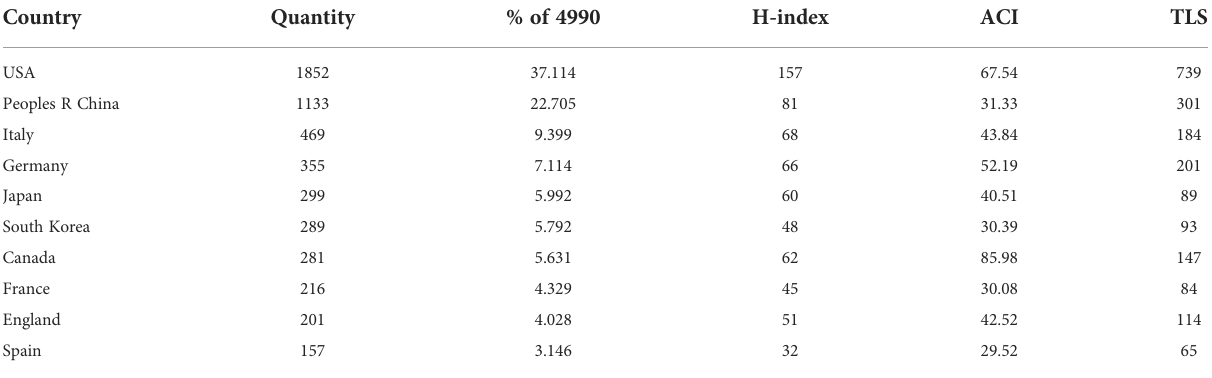
TABLE 1 The top 10 countries in research scope of glioma stem cells.